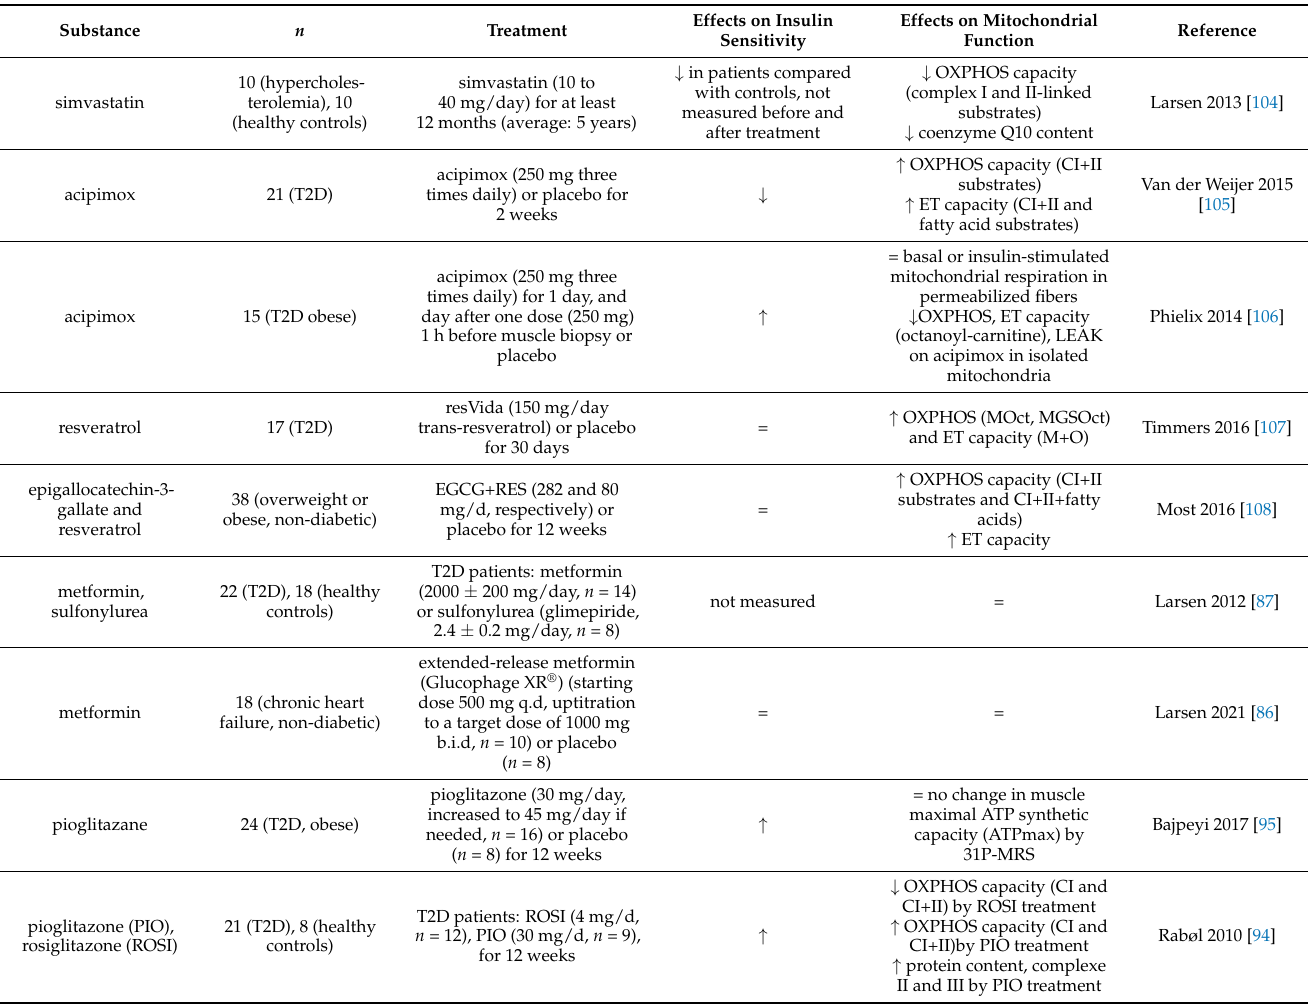
Table 1. The effects of drugs on insulin sensitivity and mitochondrial function—a list of human studies with respirometric data. T2D, type 2 diabetes; OXPHOS, oxidative phosphorylation; ET, electron transfer; LEAK; CI, complex one of the respi- ratory chain; CII, complex two of the respiratory chain; M, malate; G, glutamate; S, succinate; Oct, octanoylcarnitine; EGCG, epigallocatechin-3-gallate; RES, resveratrol; ROSI, rosiglitazone; PIO, pioglitazone. Symbols: ↑ = increase; ↓ = decrease. Substance Treatment Effects on Insulin Sensitivity Effects on Mitochondrial Function